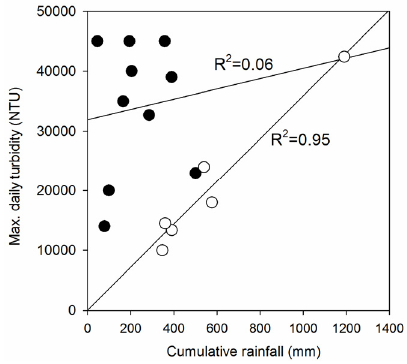
Figure 7. Linear relationship between maximum daily turbidity and 24-h event rainfall for major high-turbidity events in the periods after Morakot (black points) and before Morakot (white